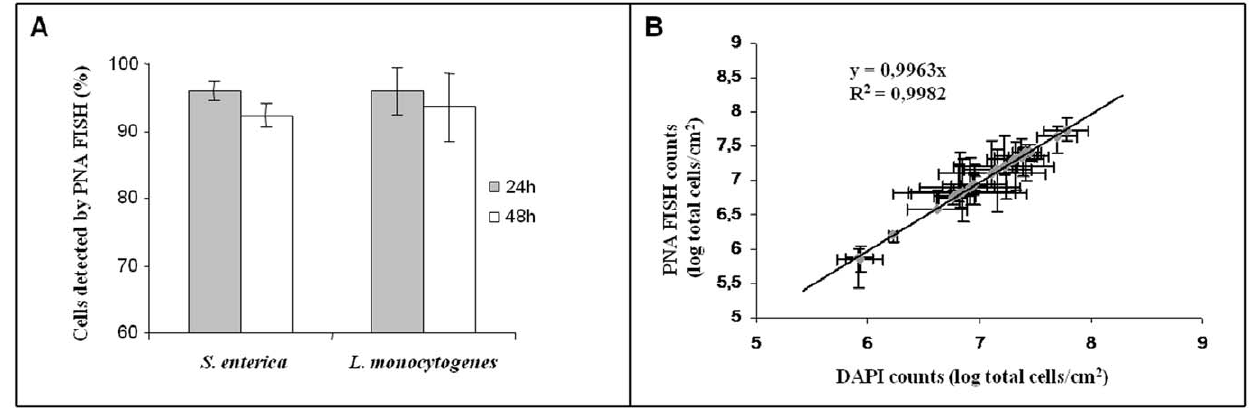
Figure 2. PNA FISH validation for biofilm samples. (A) Percentage of cells detected by PNA FISH for 24 and 48 h biofilms, in comparison with the total cells counts by DAPI. (B) Correlation between the PNA FISH counts and the DAPI counts for 24 and 48 h S. enterica e L. monocytogenes pure- culture biofilms. A high correlation between the two methods was observed and up to 48 hours at least 90% of the populations is detected by PNA FISH.